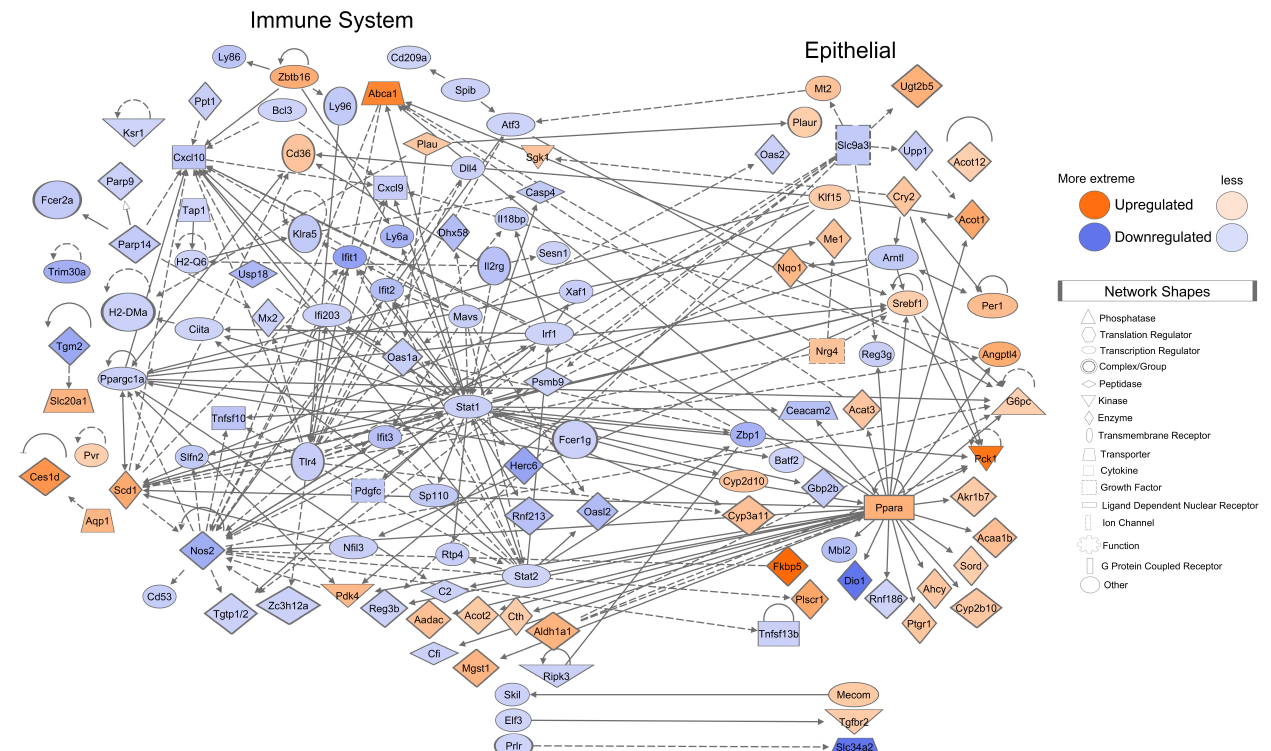
Figure 3. CR suppresses the immune system and preferentially activates epithelial cell DEG networks and discriminates the networks interconnection. IPA DB and network graphical tools were used to construct the immune system and epithelial cell-specific subsets DEGs and their encoded protein-protein interactions. 174 edges (protein interactions) were found among high significantly connected immune network interactions with several super hubs (e.g., Stat1 with 36 edges and Tlr4 with 19 edges). CR reduces the expression of a vast majority of the immune genes. CR modulates the expression of epithelium cells, activating metabolic genes, which had 58 edges within epithelial-specific proteins (e.g., Ppara pathway directly connected with 26 edges). A total of 34 edges were from immune to epithelium interactions (with a hub of Stat1, 7 edges), and 45 edges were from epithelium to immune interactions (with hub Ppara, 16 edges, mostly linked with the upregulated immune system proteins). The blue color node indicates downregulated proteins and the orange color node indicates upregulated proteins. Color intensity is based on the gene expression fold changes. Bold lines indicate a direct relationship. Dotted lines indicate an indirect